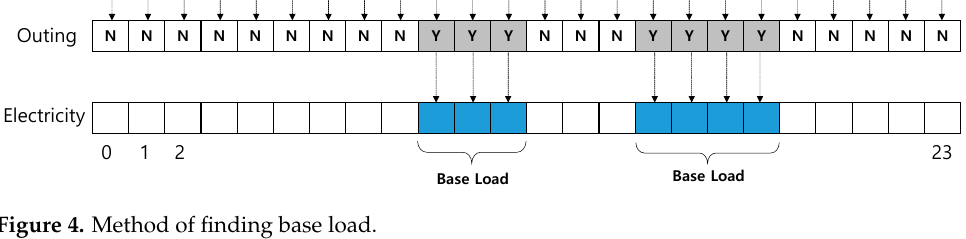
Figure 4. Method of finding base load.